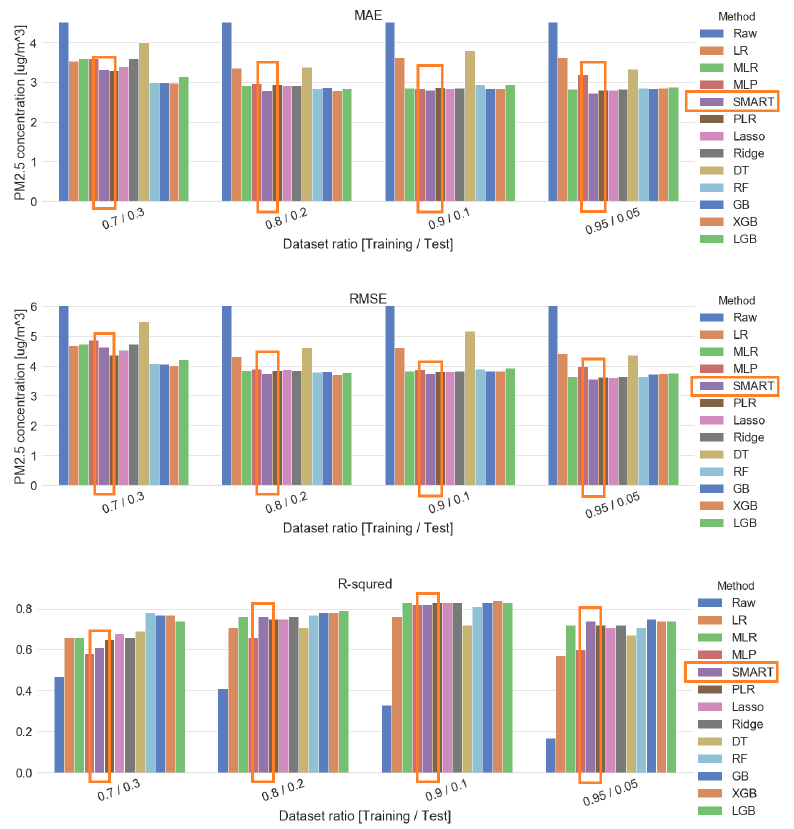
Figure 15. Comparison plot by metrics (sequential). GridsearchCV (10) found best hyperparameters as below. PLR (degree:2)/Lasso (alpha:5)/Ridge (alpha:100)/DT—decision tree (max depth = 12, min samples split =16)/RF (max depth = 6, min samples leaf = 8, min samples split = 24, n estimators = 500)/GB (learning rate = 0.05, n estimators = 200)/ XGB (colsample bytree = 1, learning rate = 0.05, n estimators = 200, subsample = 0.3)/LGB (colsample bytree = 0.5, learning rate = 0.05, n estimators = 500, num leaves = 4, reg lambda = 10, subsample =